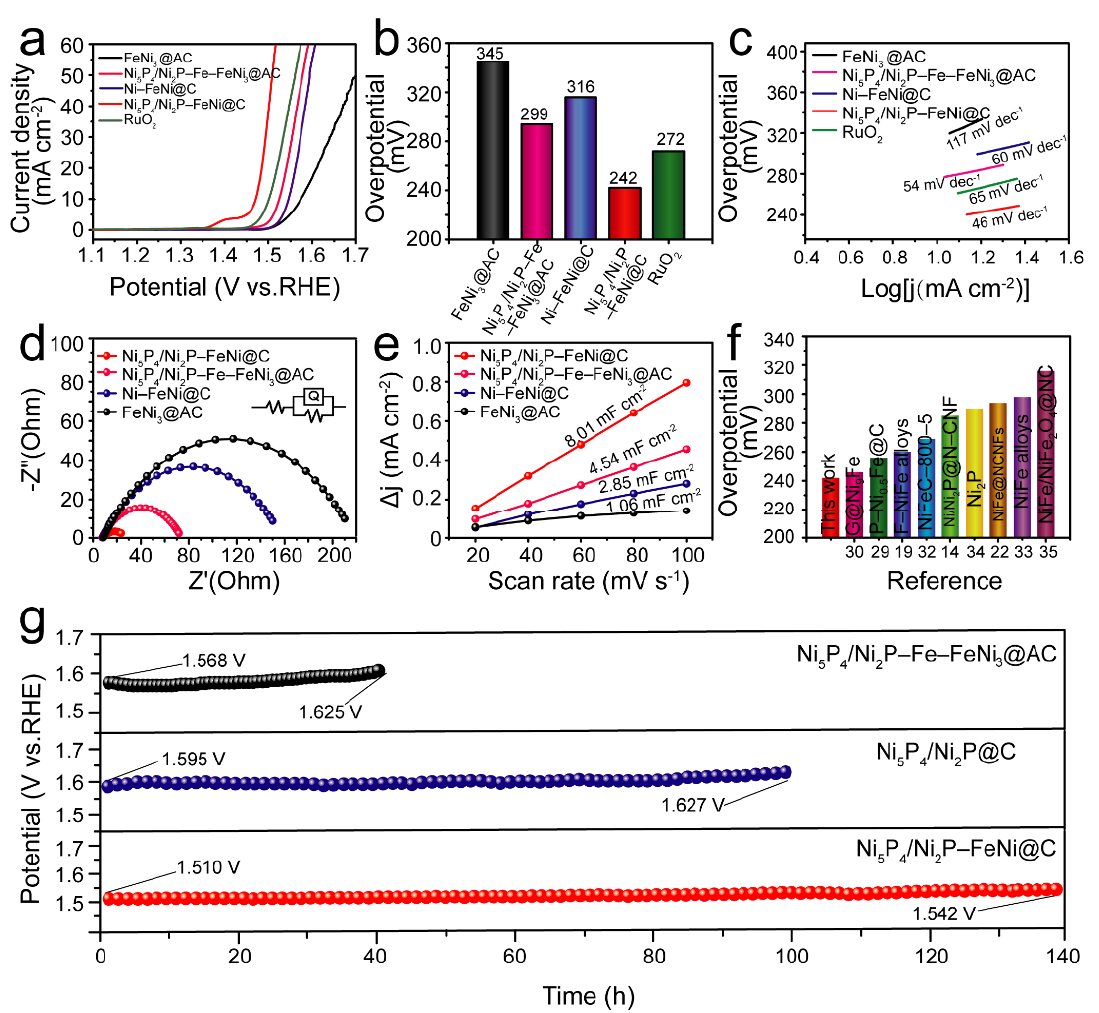
Figure 6. ( a ) OER LSV curves of FeNi 3 @AC, Ni–FeNi@C, Ni 5 P 4 /Ni 2 P–Fe–FeNi 3 @AC, Ni 5 P 4 /Ni 2 P– Figure 6. ( a )OERLSVcurvesofFeNi 3 @AC,Ni–FeNi@C,Ni 5 P 4 /Ni 2 P–Fe–FeNi 3 @AC,Ni 5 P 4 /Ni 2 FeNi@C and the commercial RuO 2 samples with 85% iR-correction in 1 M KOH. ( b ) The comparative overpotentials of catalysts at 10 mA cm − 2 . ( c ) Tafel plots derived from the polarization curves in ( a ). ( d ) Nyquist plots of the FeNi 3 @AC, Ni–NiFe@C, Ni 5 P 4 /Ni 2 P–Fe–FeNi 3 @AC and Ni 5 P 4 /Ni 2 P–FeNi@C catalysts at 1.480 V vs. RHE. ( e ) Double-layer capacitance ( C dl ) plots. ( f ) Comparison of the overpo- tentials of Ni 5 P 4 /Ni 2 P–FeNi@C (this work) and the relevant OER electrocatalysts at 10 mA cm − 2 . ( g )